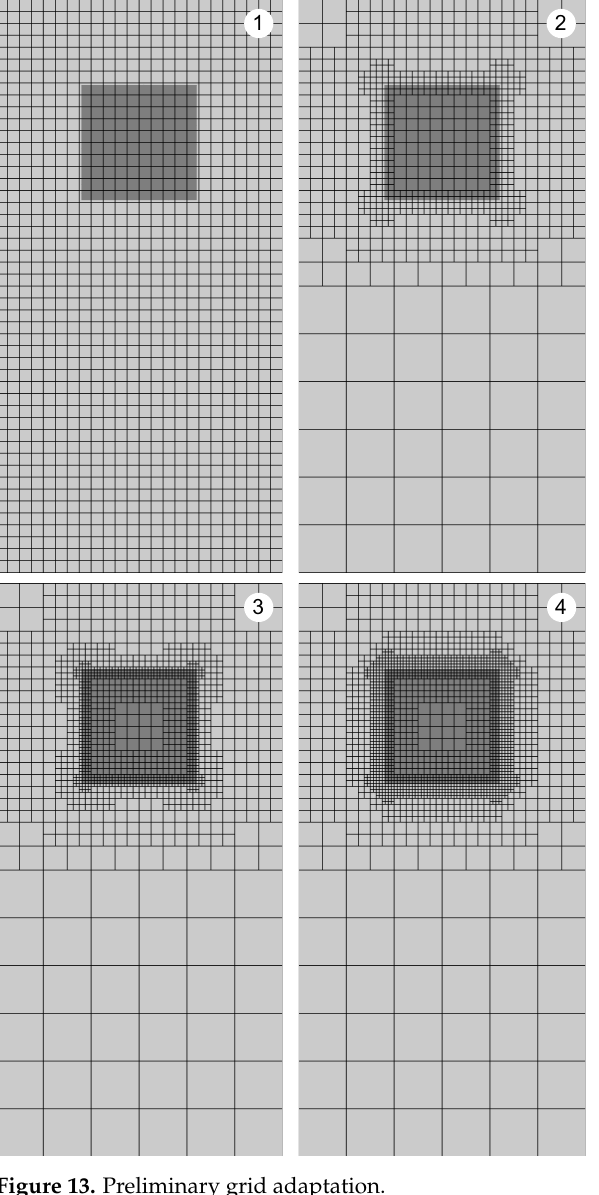
Figure 13. Preliminary grid